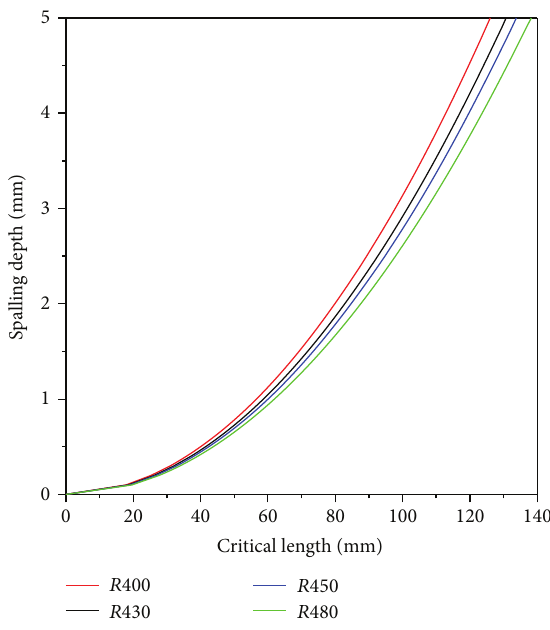
Figure 5: Critical length versus spalling